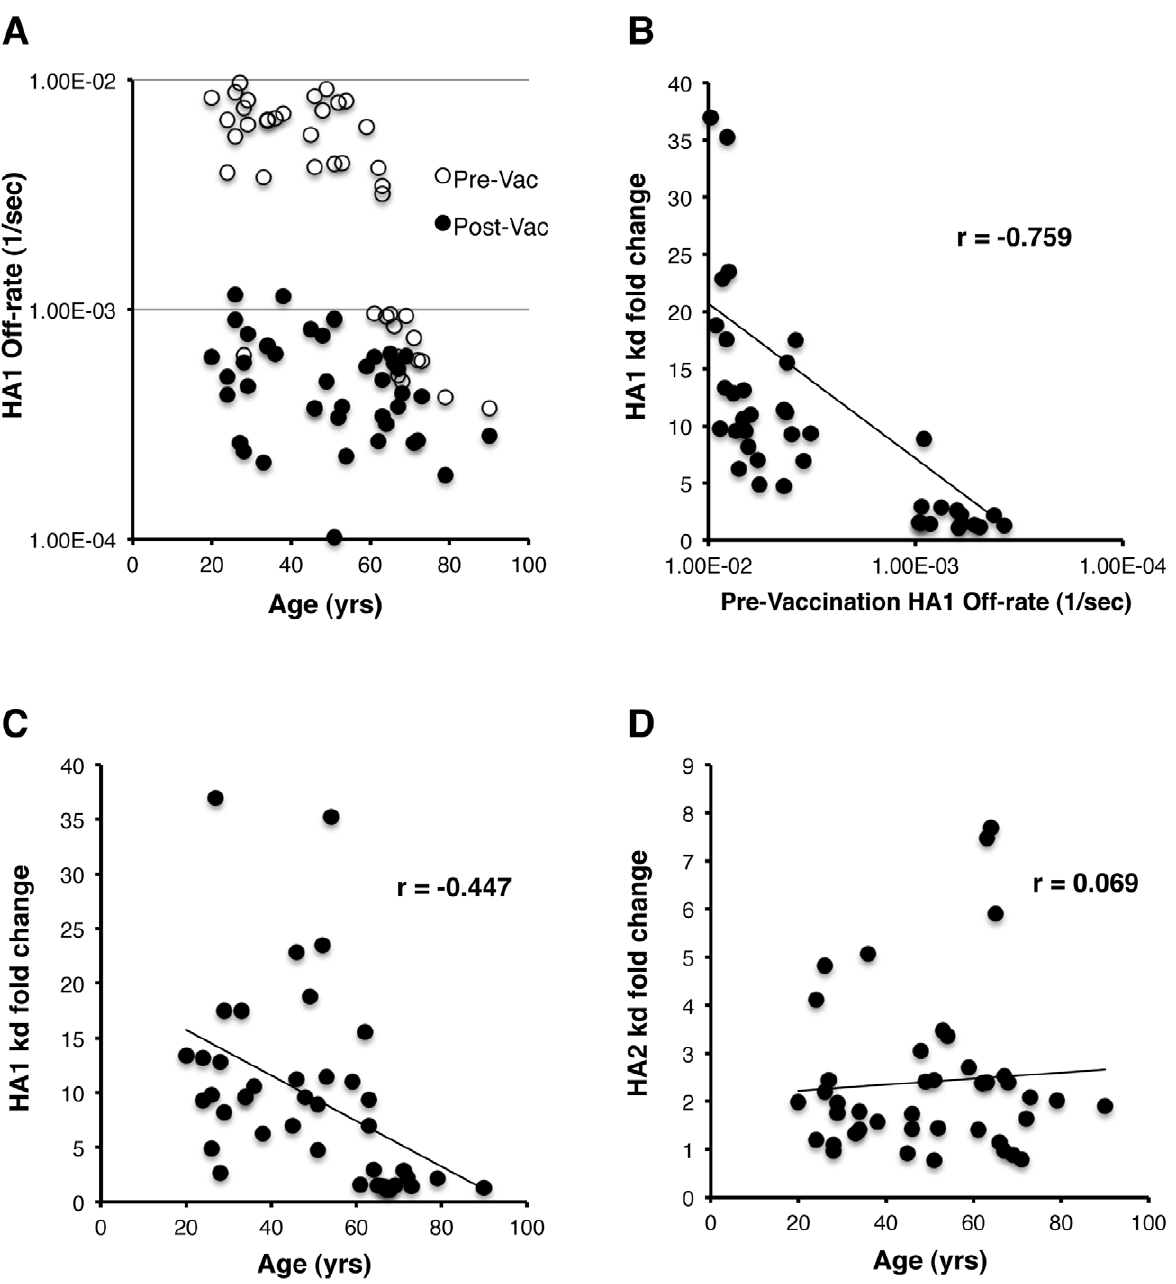
Figure 2. Antibody affinity maturation, measured by the antigen-antibody complex dissociation rate, increases for HA1 domain (but not HA2) following immunization with H1N1pdm09 subunit vaccine. (A) SPR analysis of pre- (open circles) and post- (filled circles) H1N1pdm09-vaccinated human plasma from all study participants (20–90 yrs old). Binding assays were conducted with functional H1N1pdm09 HA1 (1–330) or HA2 stalk domains [34]. Polyclonal human plasma antibody off-rate constants were determined as previously described [9]. (B) Correlation between increase in polyclonal plasma antibody affinity to HA1 domain (measured by a fold decrease of the antigen-antibody complex dissociation- rate) following H1N1pdm09 vaccination compared with the pre-vaccination off-rates against HA1. (C, D) Fold-increase in human plasma antibody affinity (decrease in antibody off-rate) after vaccination against the globular HA1 domain (C) or HA2 stalk domain (D) compared with the age of the vaccinated individuals. Post-H1N1pdm09 vaccination increase in polyclonal antibody affinity to the HA1 domain (but not HA2) was inversely correlated with subjects’ age. exposure to foreign antigen. The GC formation depends on close that circulating peripheral B cells could be used to measure AID interactions between antigen specific B and follicular helper T cells mRNA baseline levels and induction after vaccination, thus (T FH ) [17–18] [19,20]. In humans it is very difficult to access the mimicking the earlier GC reactions. We have previously shown that AID can be induced in cultures of B cells stimulated not only lymph nodes for large scale studies. However, there is evidence